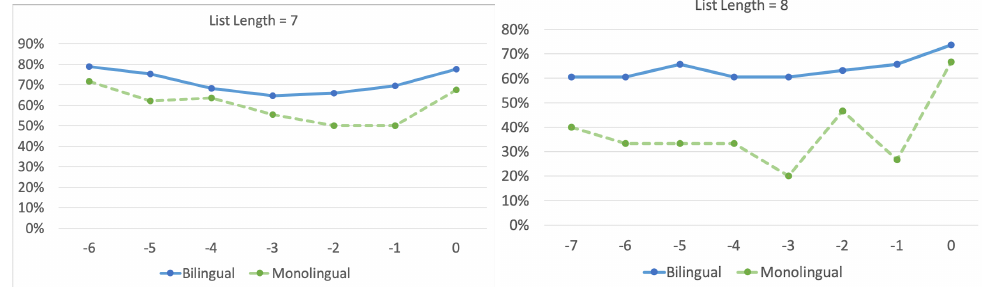
Figure 7. Digit span task: mean accuracy at each serial position for 7-digit ( right ) and 8-digit sequences ( left ). The terminal item is labeled with a 0, and each item preceding it is labeled in terms of its distance from the terminal item (e.g., − 1 for the penultimate item, − 2 for the antepenultimate item,